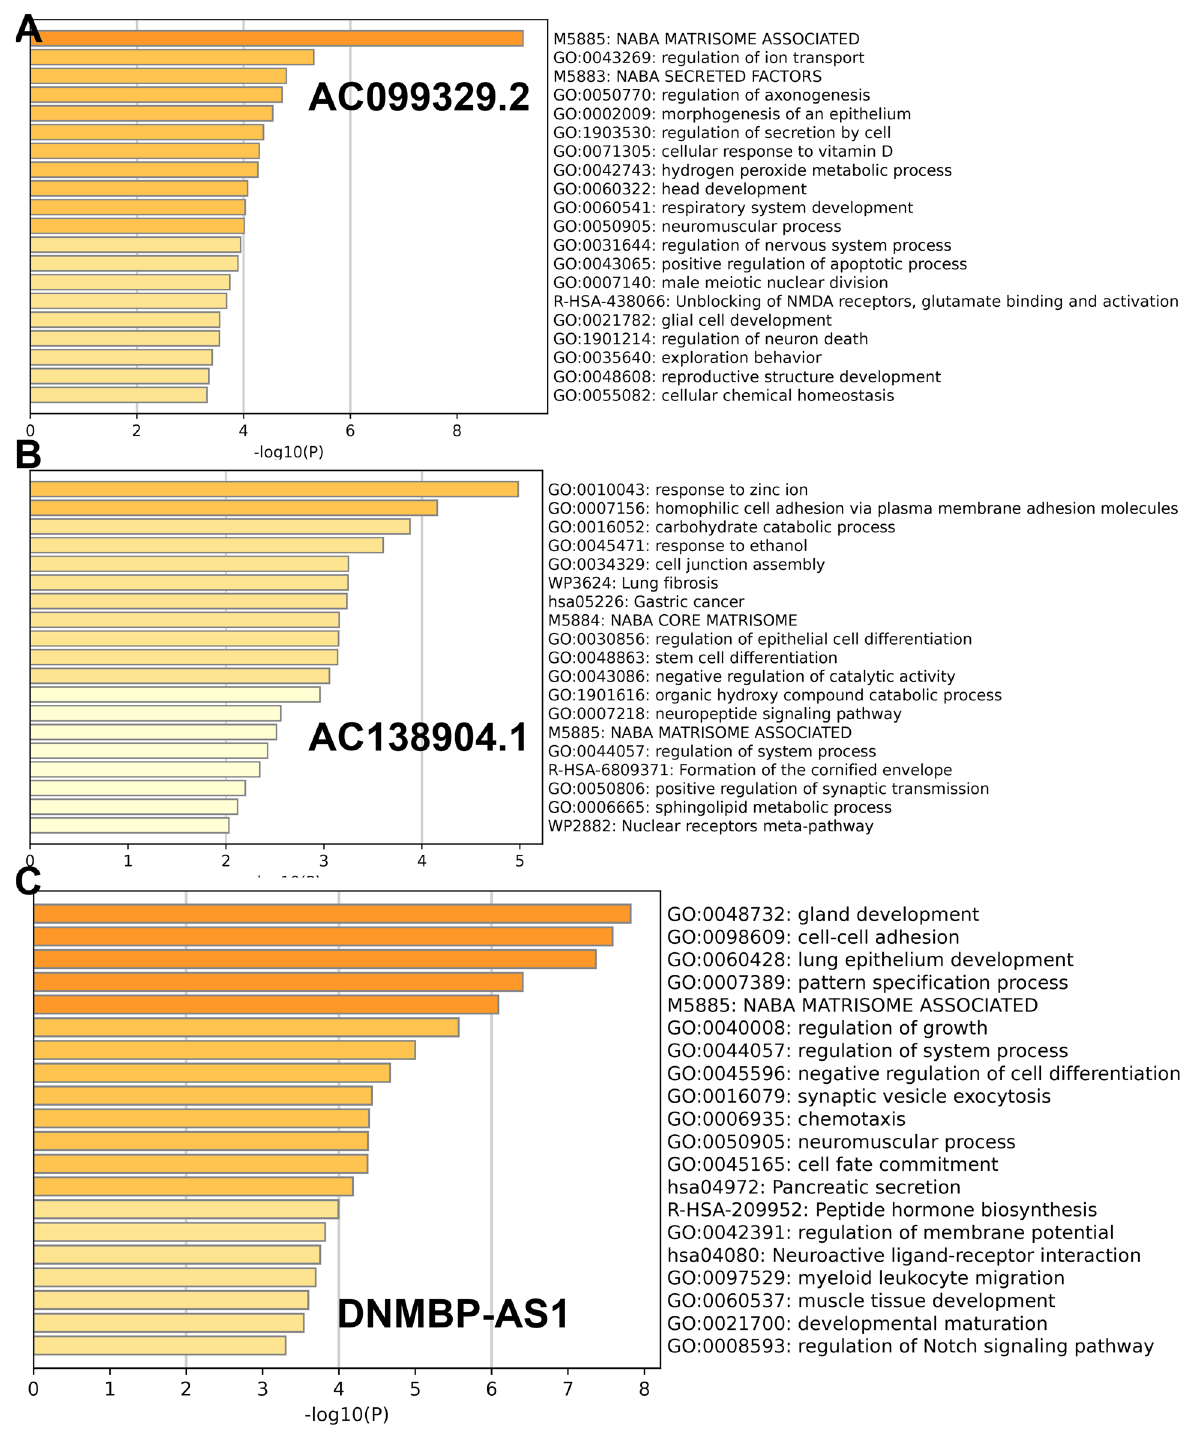
Figure 11. Functional enrichment analysis of lncRNAs. ( A ) AC099329.2. ( B ) AC138904.1. ( C )